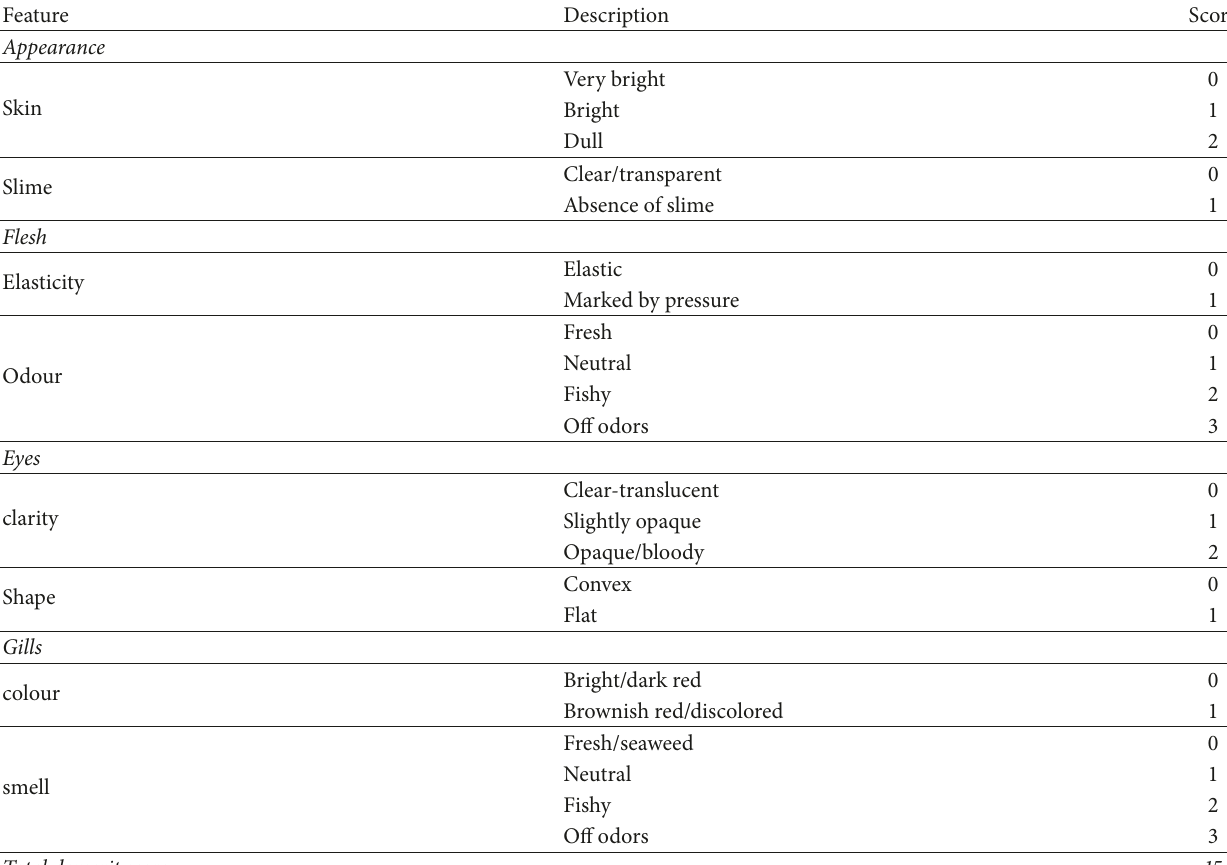
Table 5: QIM scheme used for gilthead sea bream (Sparus aurata)